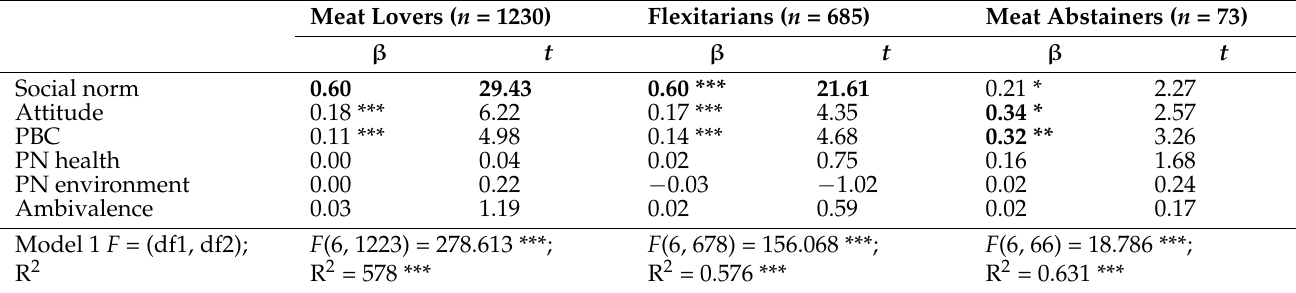
Table 5. Hierarchical regression analyses for 2019 with drivers as independent variables and intention as the dependent variable for meat lovers, flexitarians, and meat